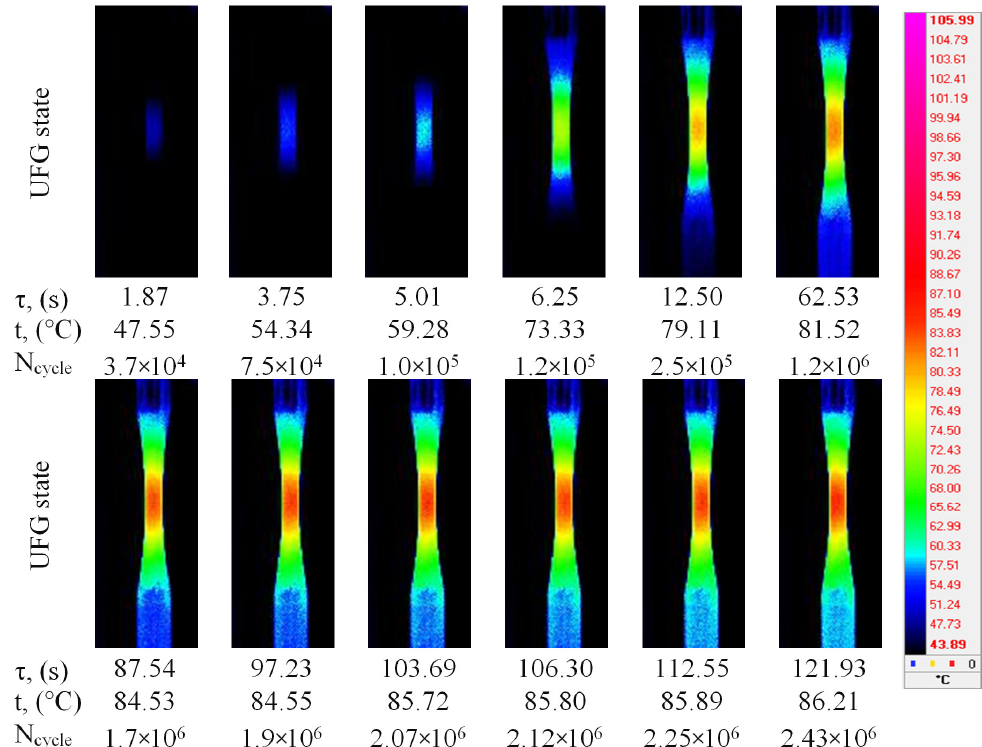
Figure 9. Thermal field images in the infrared zone, during the cyclic loading of UFG Ti-45Nb sample: τ (s)—time, N—number of loading cycles, t—maximal temperature on the surface.